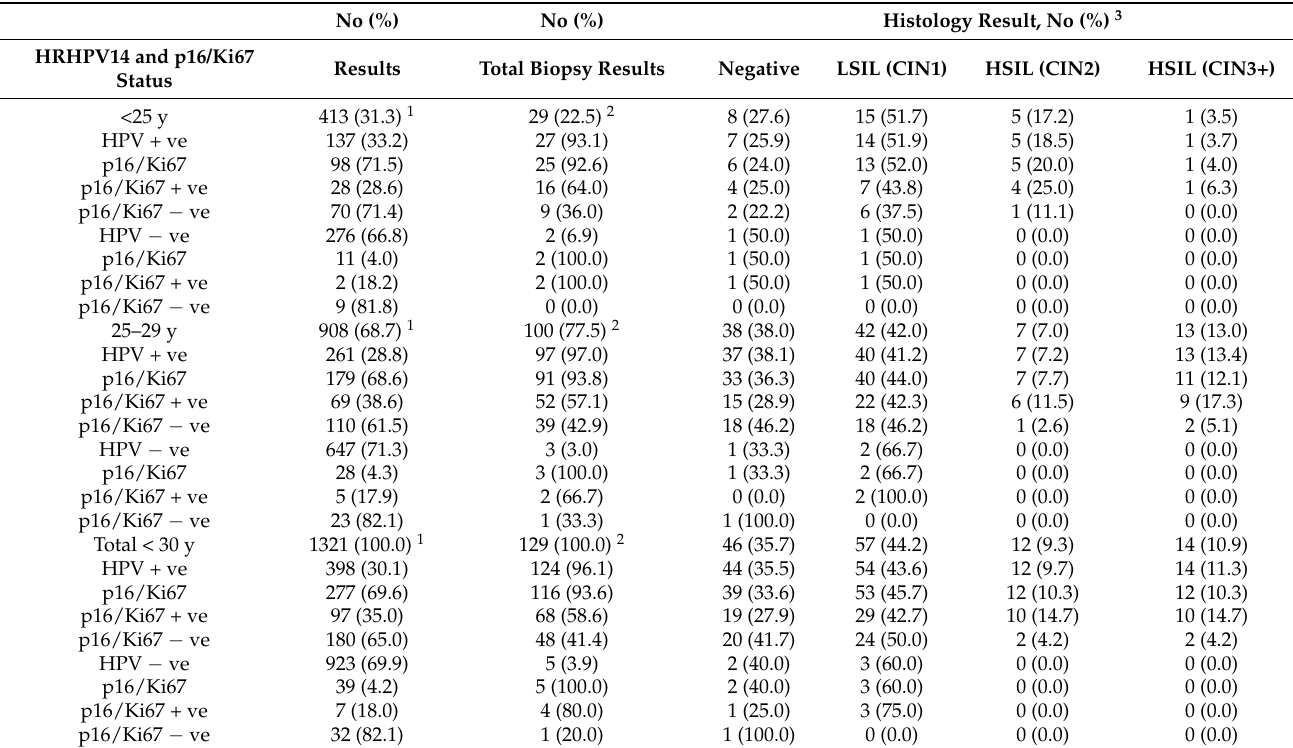
Table 4. Age-stratified biopsy results (<25, 25–29 and <30 years) with HRHPV14 and p16/Ki67 status from baseline to final study group.